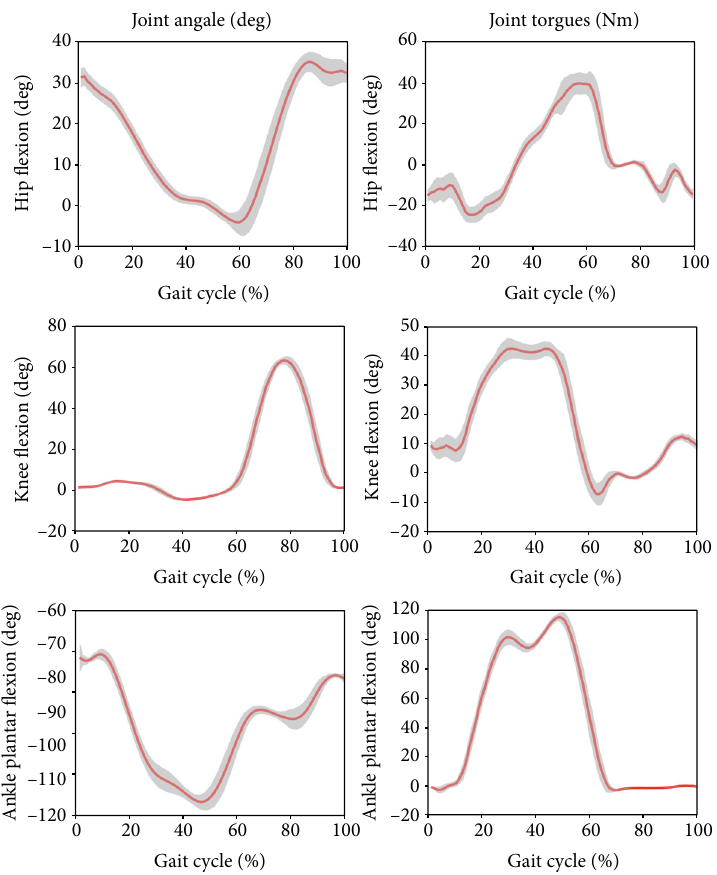
Figure 13: The mean (red) and standard deviation (shaded) of joint angles and torques for transfemoral prosthesis user PRO1, trial 3, during the preferred walking speed of 0.8m/s. The mean and standard deviation are calculated over 30 gait cycles.